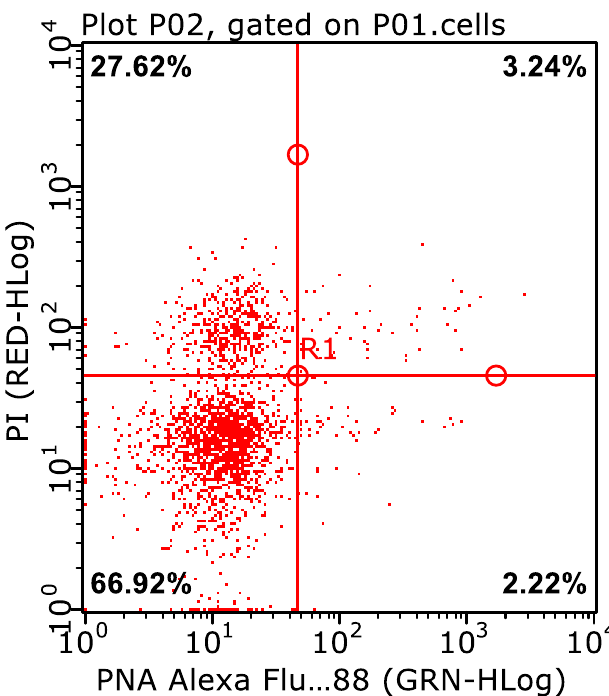
Figure 5. An example of a dot plot with live spermatozoa with intact acrosomes in the Control group in the lower left quadrant (86.92%): PNA-PI- (PNA, PNA Alexa Fluor 488–lectin from Arachis hypogaea ; PI, propidium iodide).